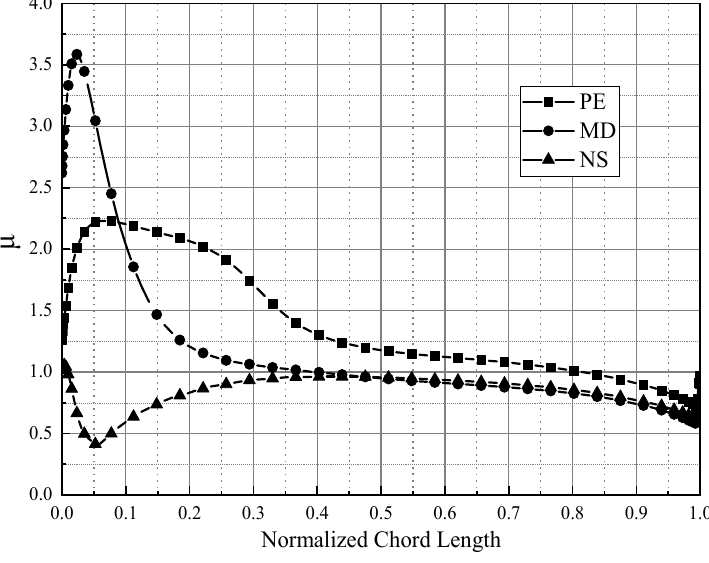
Figure 14. Momentum distribution of tip clearance flow along chord.